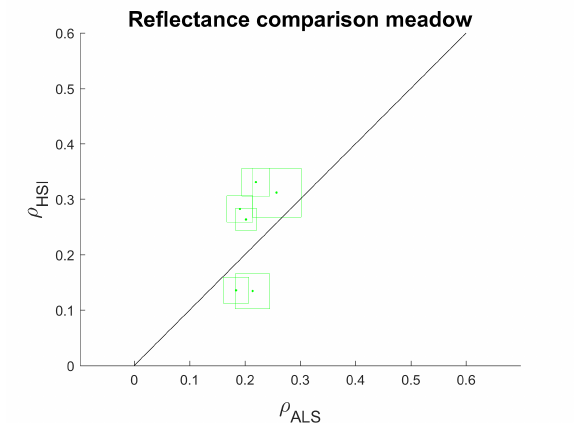
Figure 10: Reflectance comparison for meadows. The size of the green squares corresponds to the area covered by the single mead- ows.